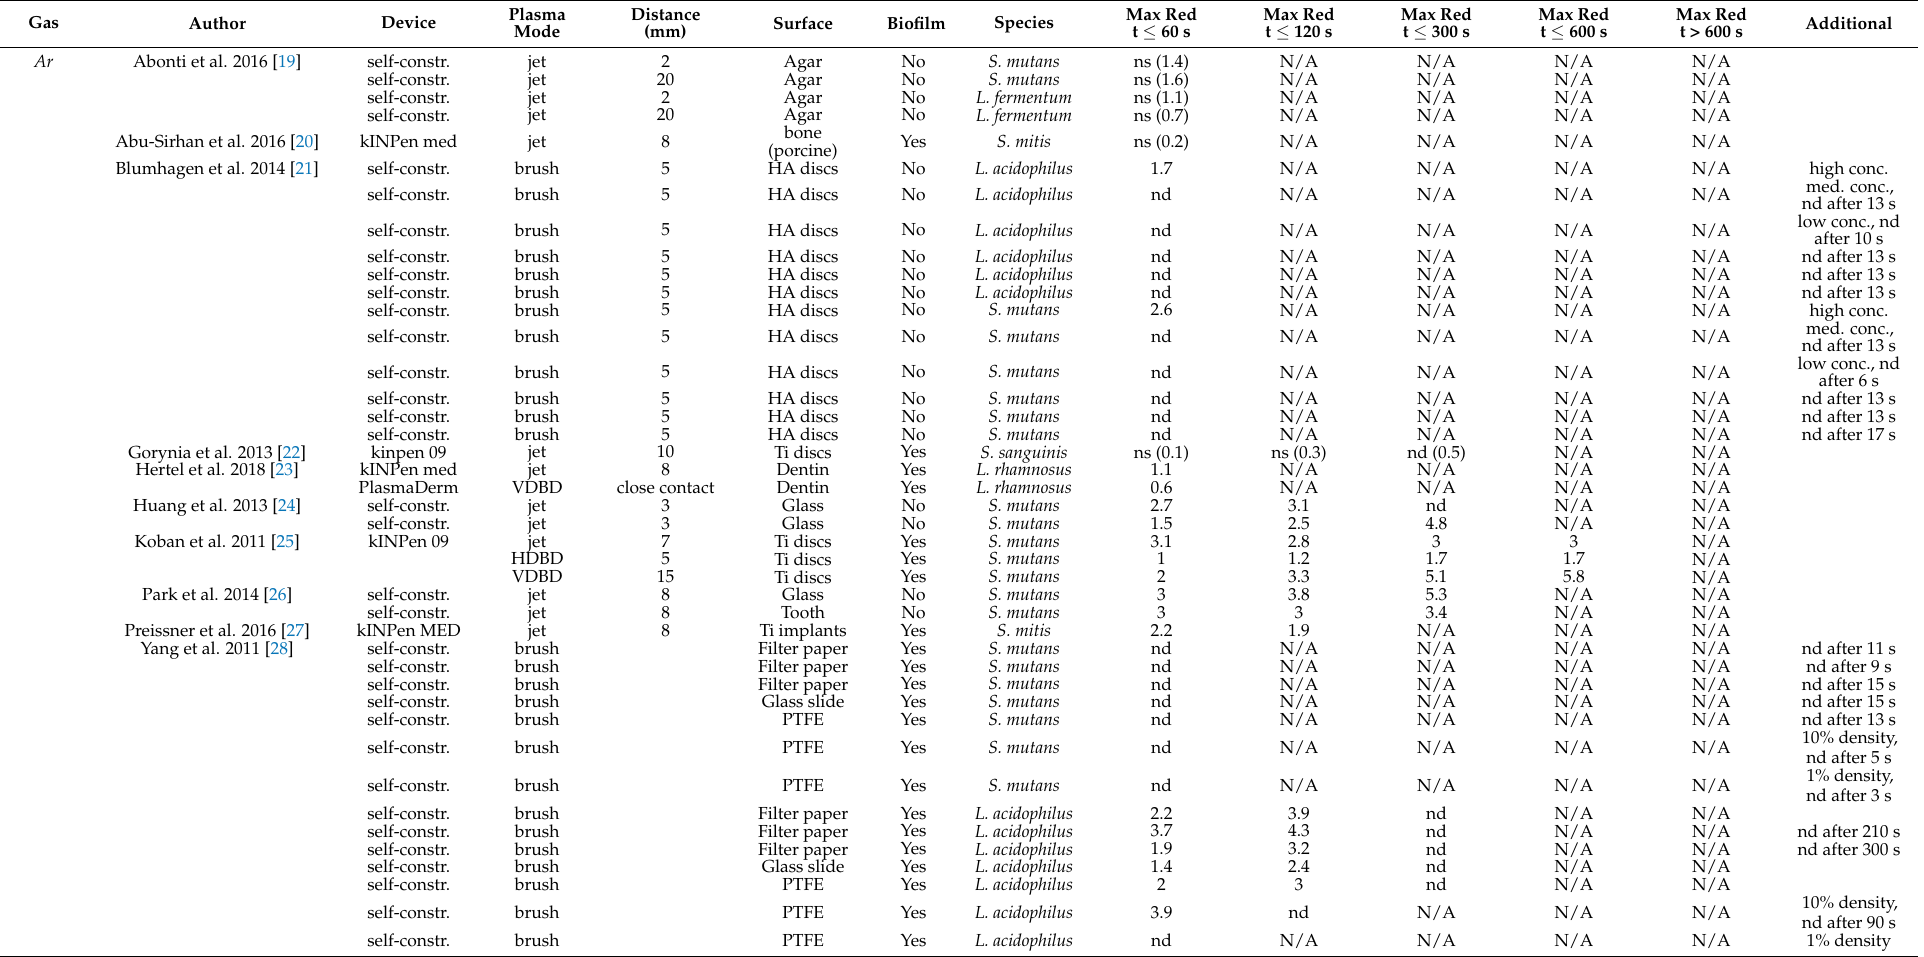
Table 2. Effect of CAP on bacteria associated with dental caries; Abbreviations: CD: corona discharge; conc.: concentration; DBD: dielectric barrier discharge; HA: hydroxyapatite; HDBD: hollow dielectric barrier discharge; max red: maximal reduction; med.: medium; pos.: positive; PTFE: polytetrafluorethylene; N/A: not available; nd: non-detectable; neg.: negative; ns: non-significant; self-constr.: self-constructed; Ti: titanium; VDBD: volume dielectric barrier